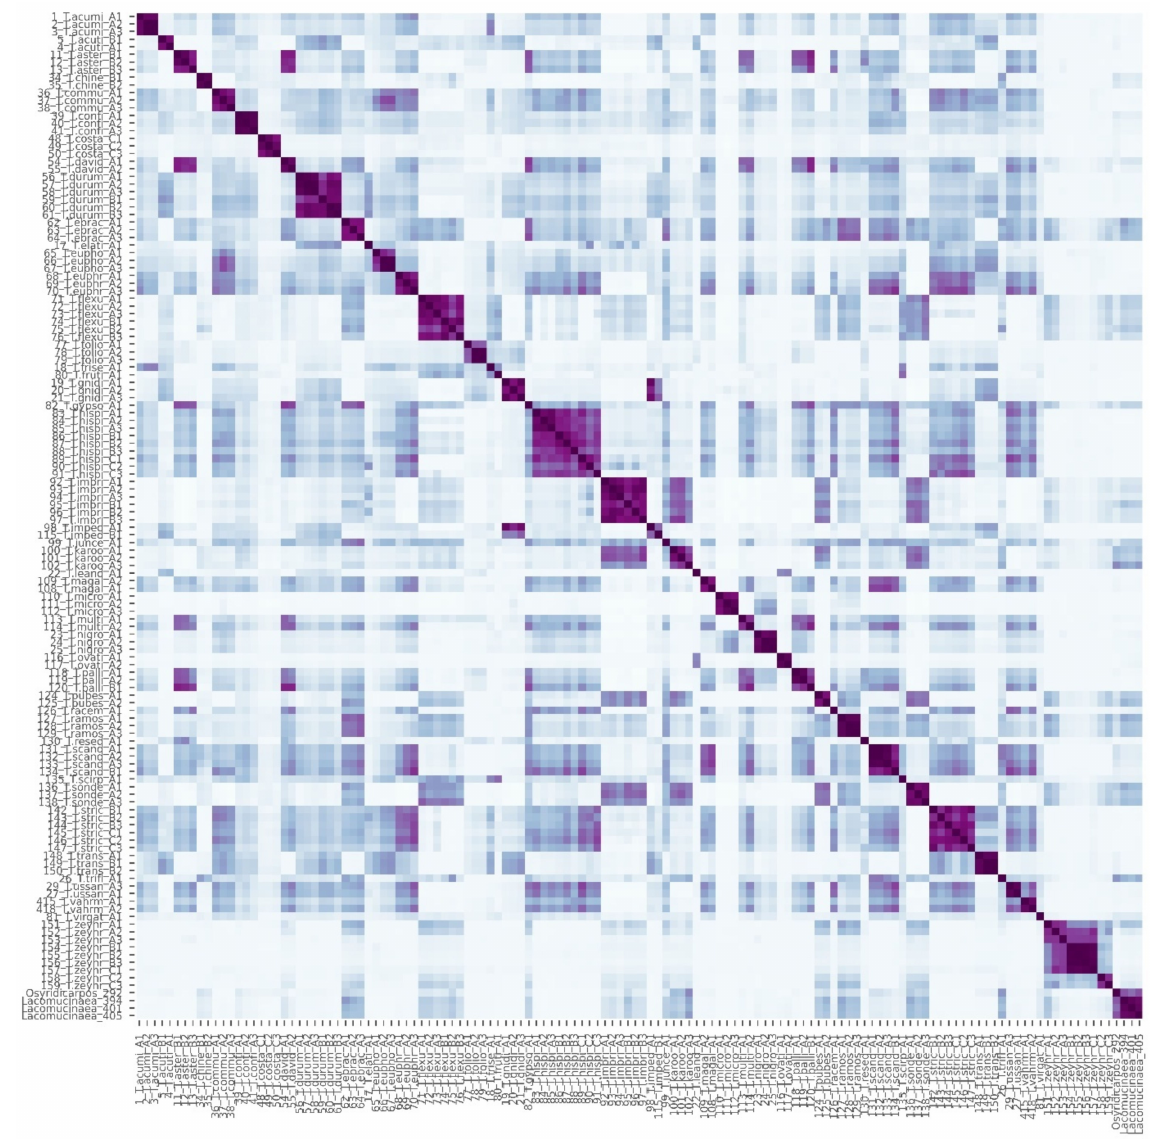
Figure 4. Correlation heatmap showing the similarities among 128 samples of 46 Thesium species, as well as sister genera Osyridicarpos and Lacomucinaea , based on phenolic compound composition. Darker colours indicate higher similarity between samples. Species names corresponding to sample labels are provided in Table